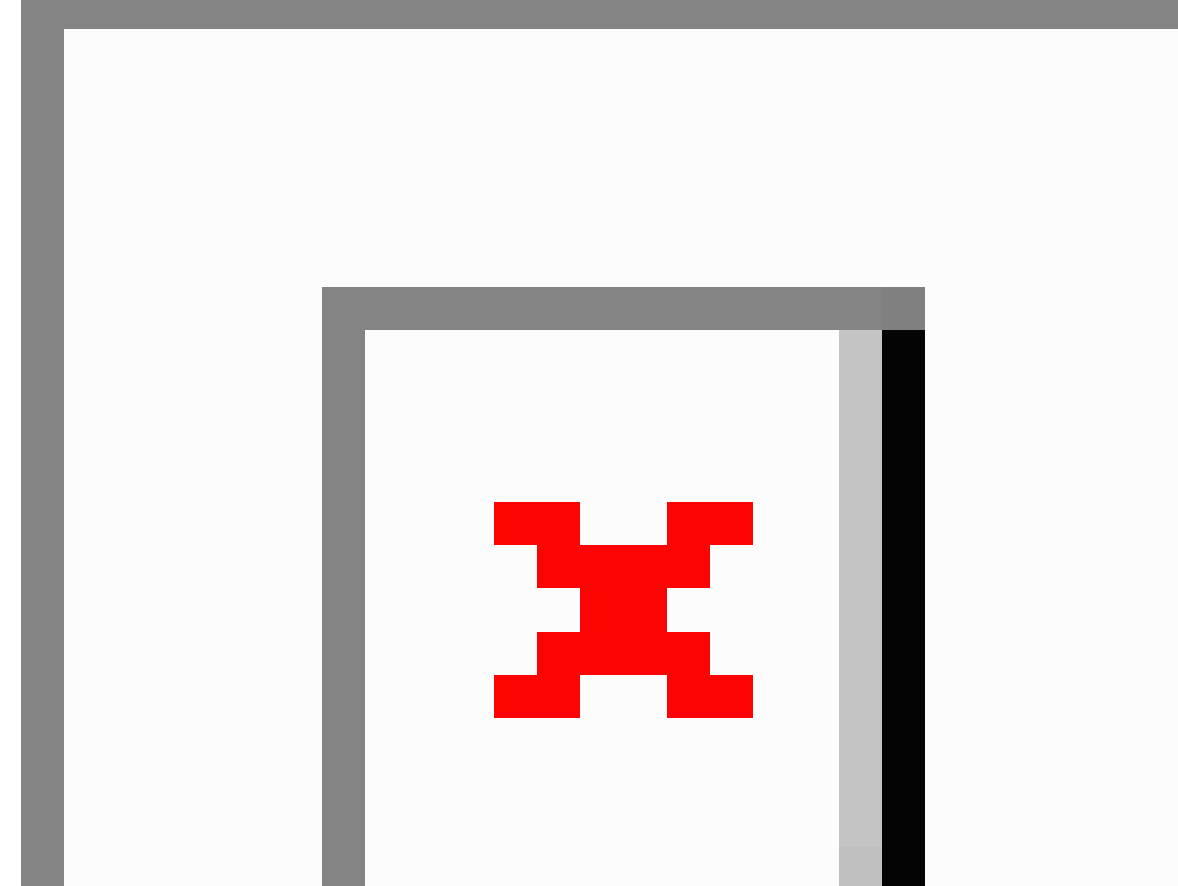
Figure 2. Receiver operating characteristic curves of the malnutrition, inflammation, and stroke model for 2-year survival prediction. AUC: area under the